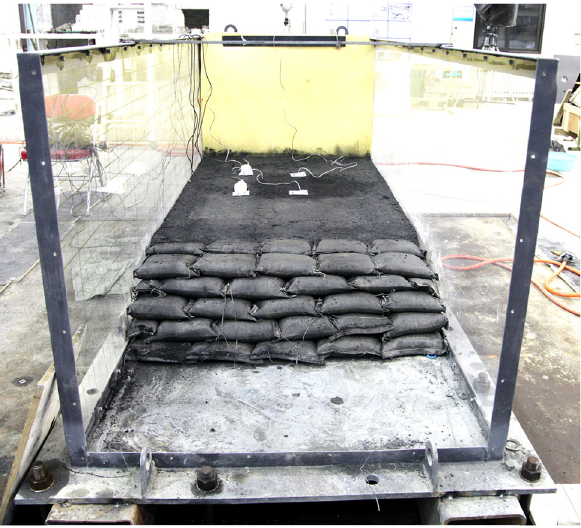
Figure 5: Illustration of model construction.